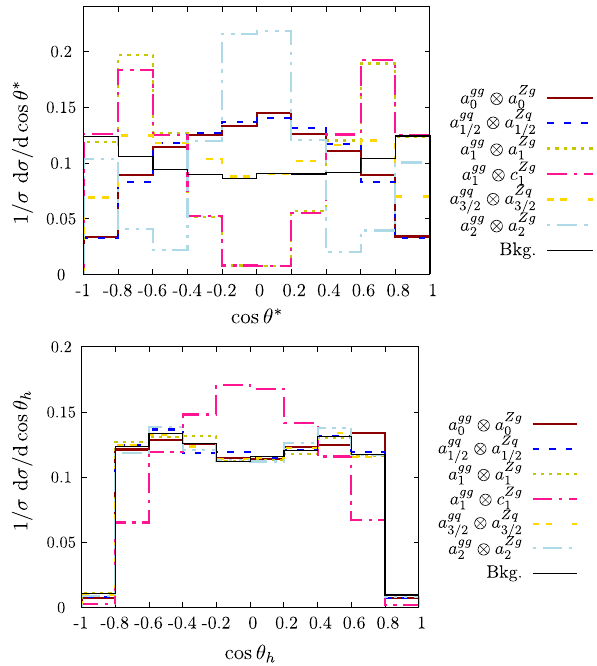
Fig. 5 Impact of energy mis-measurements on the cos θ (cid:20) distribution for our benchmark scenario of M = 500 GeV for two representative